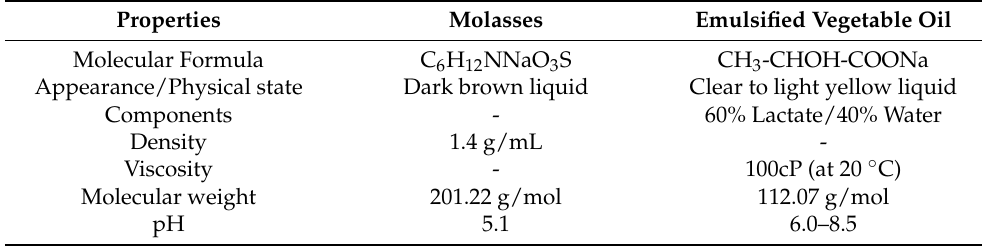
Table 3. Properties and characteristics of molasses and EVO used in the experiments. Properties Molasses Emulsified Vegetable Oil Molecular